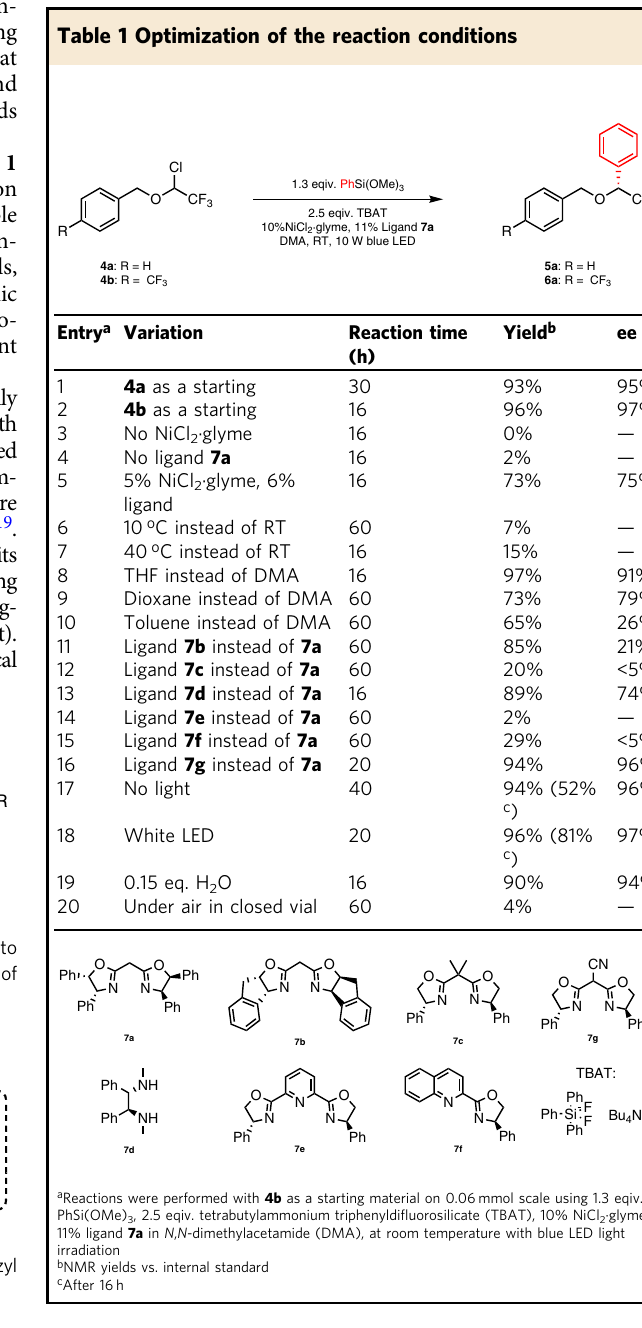
Table 1 Optimization of the reaction conditions